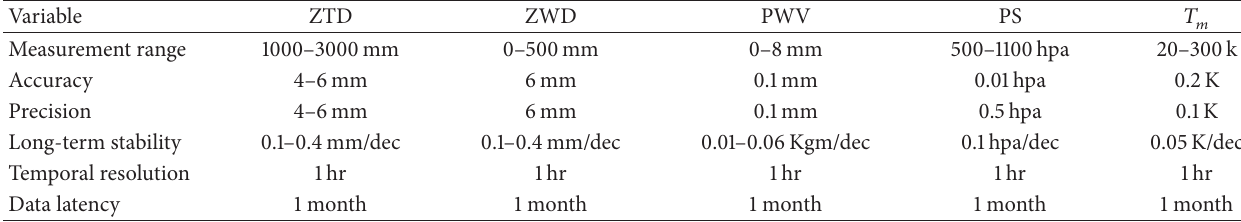
Table 1: GRUAN GNSS product requirements (modified after [14]).